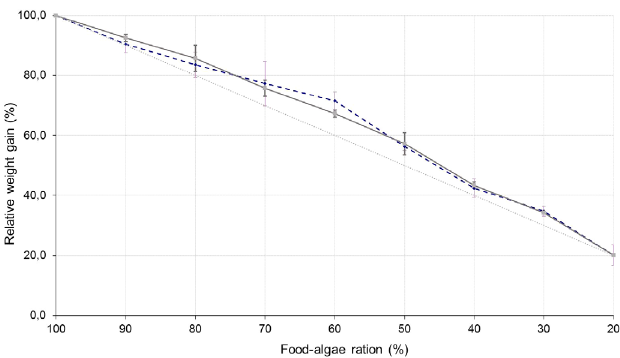
Fig. 1. Mean and con fi dence interval of the percentage relative weight gain [RWG = 100*SGR ration /SGR 100) for both periods according to the amount of food ( P. palmaria ). Continuous line: 1st period (9 December to 22 January), discontinuous line: 2nd period (22 January to 8 March), gray line: theoretical curve (Experimentation